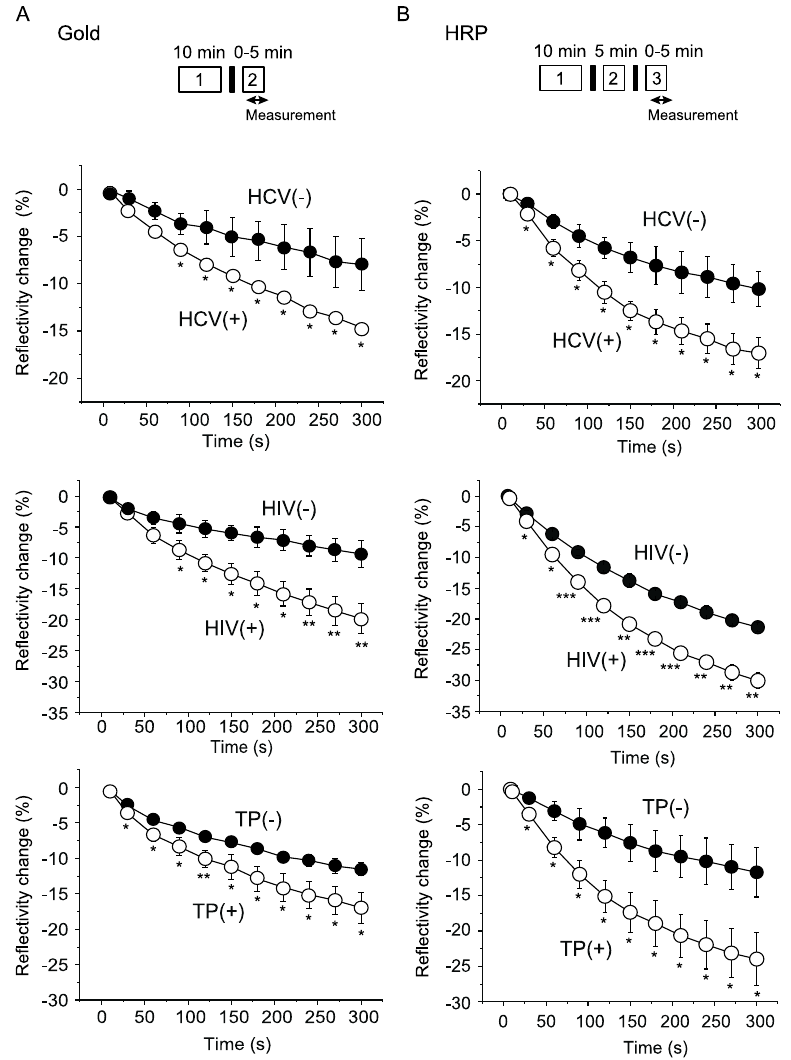
Figure 3. Detection of antibodies against HCV, HIV and TP with a WM sensor. ( A ) Signal enhancement using gold nanoparticle-conjugated antibody. Experimental procedure: 1, reaction between antigens fixed on a chip and antibodies against HCV, HIV or TP; 2, reaction between antibody against HCV, HIV or TP and conjugated secondary antibody. ( B ) Signal enhancement using HRP-conjugated antibody. Experimental procedure: 1 and 2 as ( A ); 3, reaction for AEC coloring. * p < 0.05, ** p < 0.01 versus control plasma (n = 3 − 4 for each group).